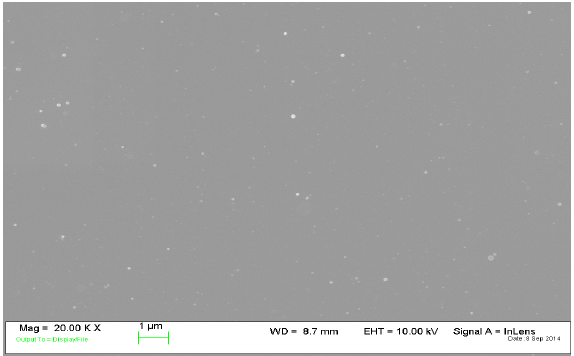
Figure 8. SEM micrograph of sample K7: TiN film on Si single crystal substrate.